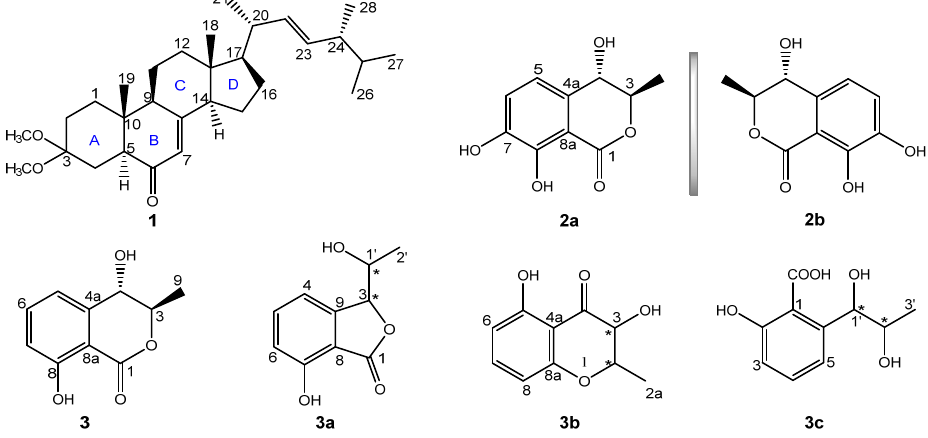
Figure 1. Structures of 1 – 3 and the reported structures of 3a – 3c